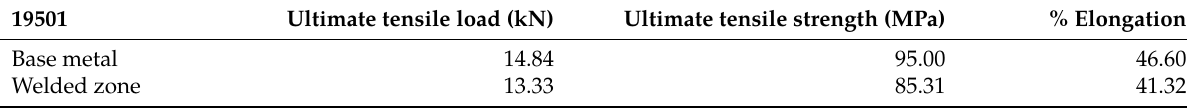
Table 3: Mechanical properties of base metal and FSW welded zone.